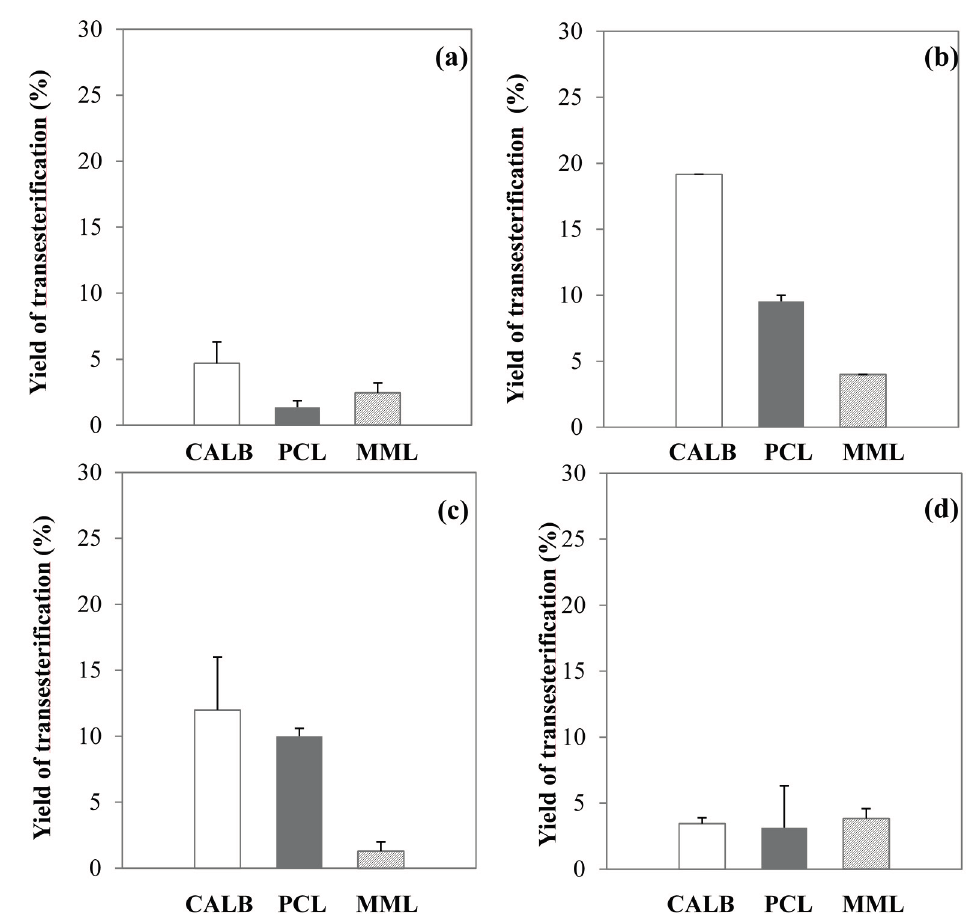
Figure 1. Yield of Kraft lignin transesterification with ethyl oleate (0.24 M) as acyl donor at 48 h catalyzed by the immobilized lipase B from Candida antarctica (CALB) in white bar, immobilized lipase from Pseudomonas cepacia (PCL) in grey bar and immobilized lipase from Mucor miehei (MML) in striped bar in dioxane ( a ); in [C 4 C 1 im][PF 6 ] ( b ); in [C 4 C 1 im][MeSO 4 ] ( c ); and in [C 4 C 1 im][OTf] ( d ) at 55